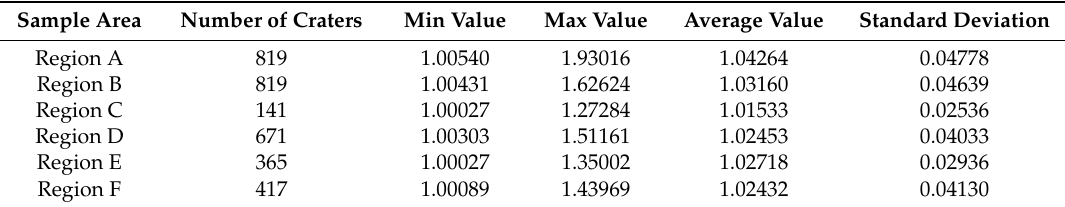
Table 9. Heterogeneity of craters in different experimental areas using the circularity.